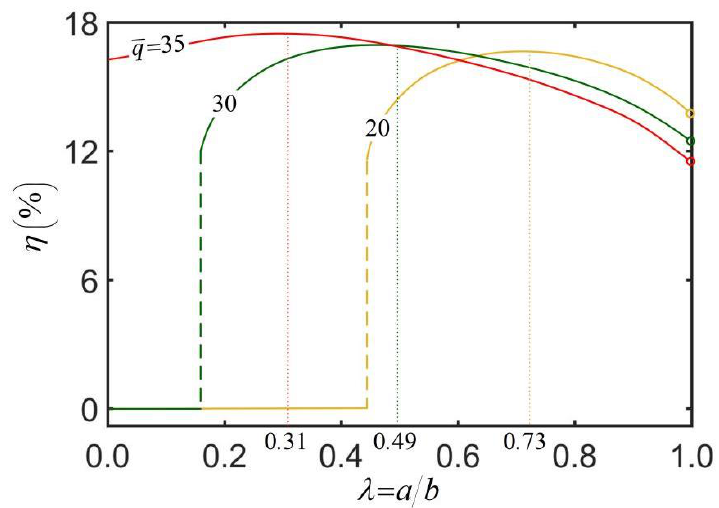
Figure 8. The dependence of energy efficiency η on the radius ratio λ and dimensionless heat flux q . The parameters are h = 0.3, κ z = 0.025, C T = 5 × 10 − 3 , C f = 0.45, and θ 0 = 0.2. There exists an optimal radius ratio that maximizes the energy efficiency of the thick-walled cylindrical rod, and the optimal radius ratio decreases as the heat flux increases.